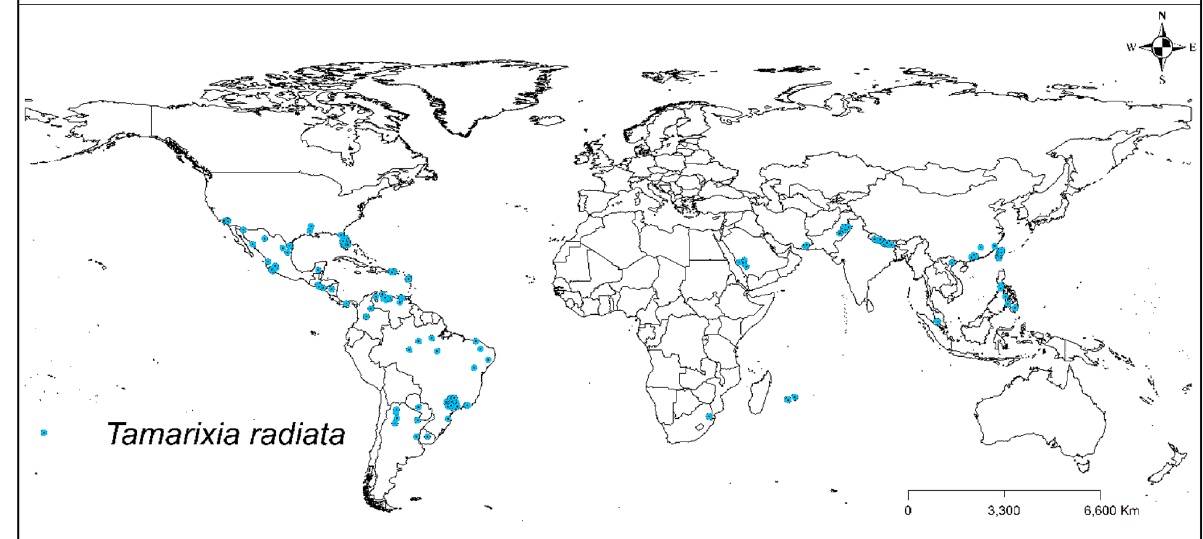
Figure 2. Tamarixia radiata occurrence worldwide. ESRI ArcMap 10.2.2: (https:// suppo rt. esri. com/ en/ Produ cts/ Deskt op/ arcgis- deskt op/ arcmap/ 10-2- 2# downl